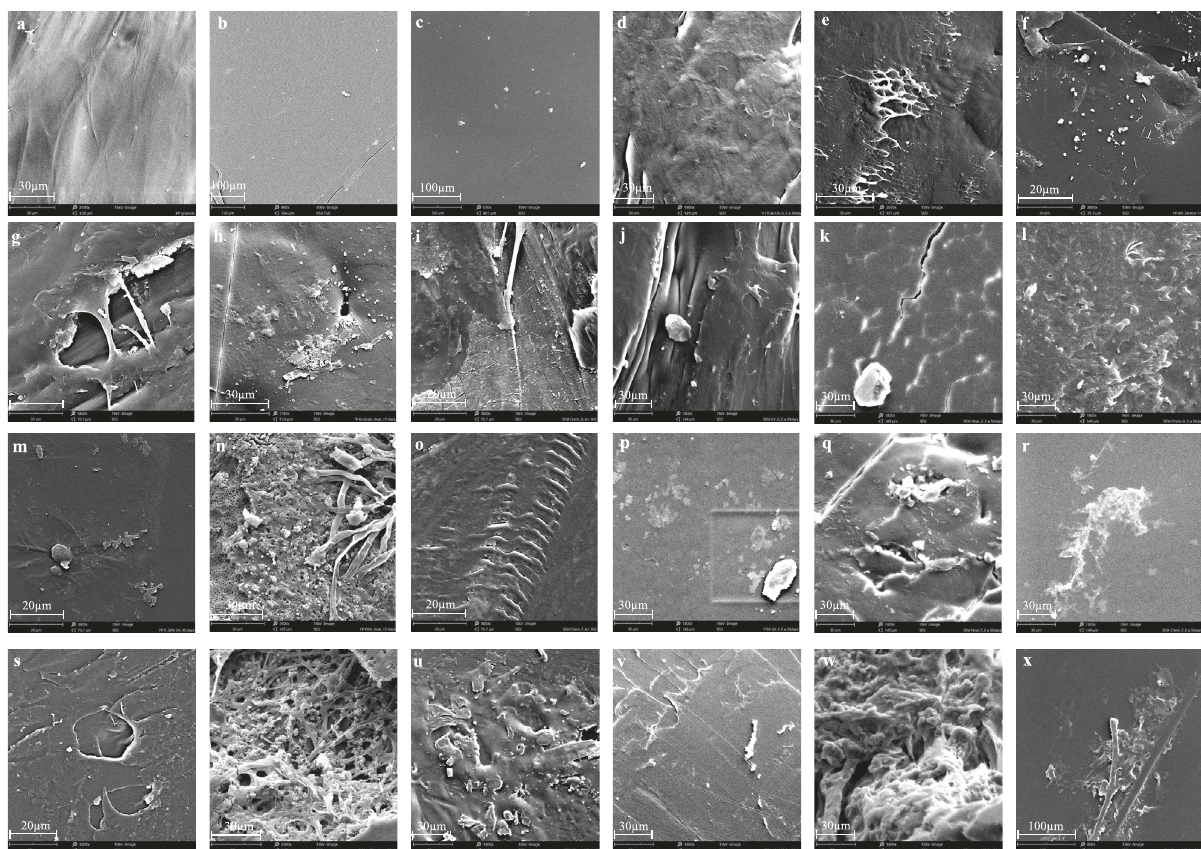
Fig. 6 SEM analyses. a – f SEM micrographs of PP without pre-treatment (WPC – a GPP, b FPP, c MFPP) and pre-treated ( d , UV-GPP; e , H-FPP and f , FR-MFPP) controls. g – l , GPP samples of with pre-treatments incubated in both fungi where g – i are UV g , heat h , and Fenton-treated i GPP incubated in A. terreus while j – l are UV j , heat k , and Fenton-treated l GPP incubated in E. album . m – r , FPP samples of with pre-treatments incubated in both fungi where m – o are UV m , heat n , and Fenton-treated o FPP incubated in A. terreus while p – r are UV p , heat q , and Fenton- treated r FPP incubated in E. album . s – x MFPP samples of with pre-treatments incubated in both fungi where s – u are UV s , heat t , and Fenton- treated u MFPP incubated in A. terreus while v – x are UV v , heat w , and Fenton-treated x FPP incubated in E. album